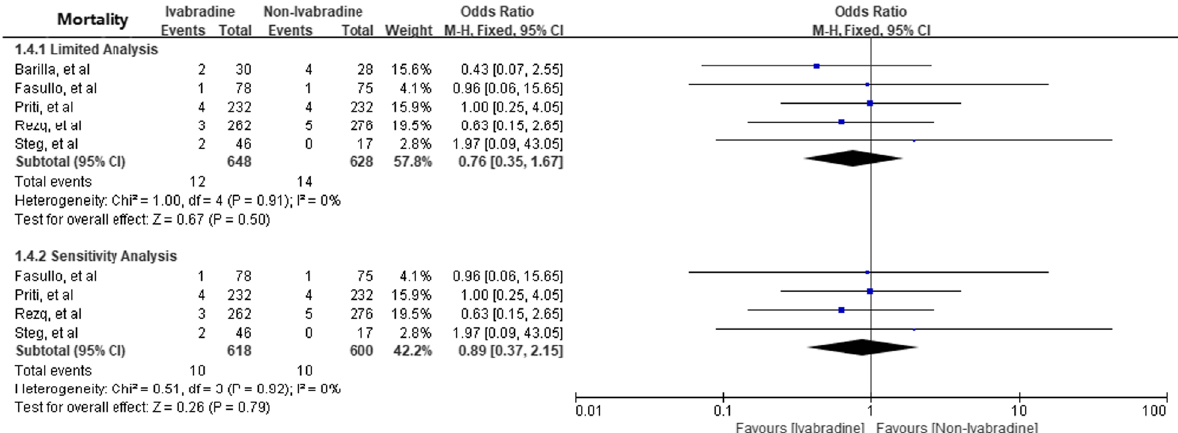
Fig. 6 Effect of Ivabradine on All-cause